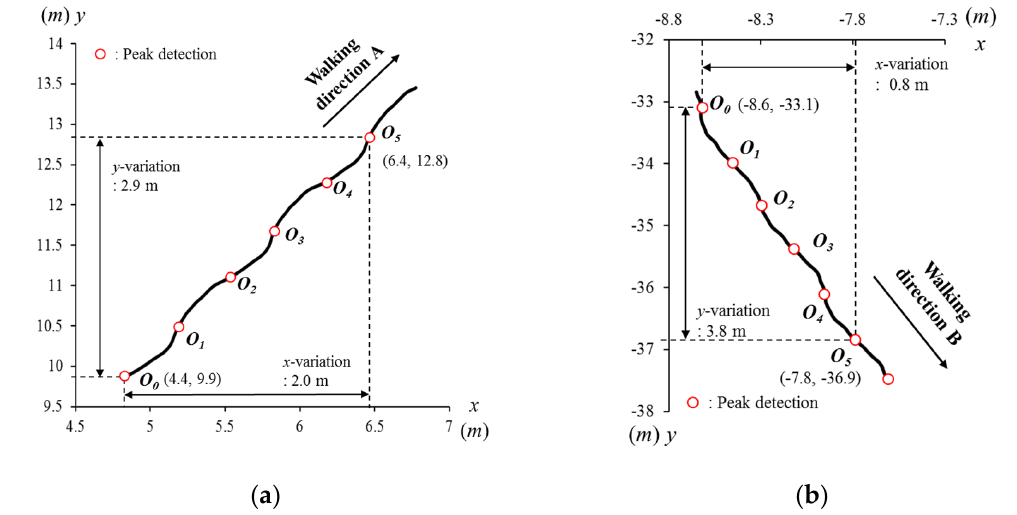
Figure 3. Head trajectories on the x - y coordinate systems of ( a ) the participant A (P A ) in the walking direction A ( W A , the north-west) and ( b ) the participant B (P B ) in the walking direction B ( W B , the north-east). Their x - and y -positions at peaks are incomparable because the positions have no common reference and also vary depending on walking directions and the global positions.